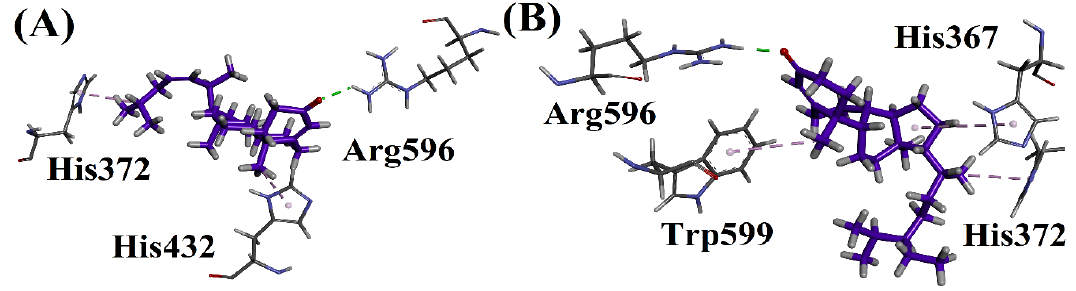
Figure 6. ( A ) Interactions of compound 1 and ( B ) Interactions of compound 2 in 6N2W active site.